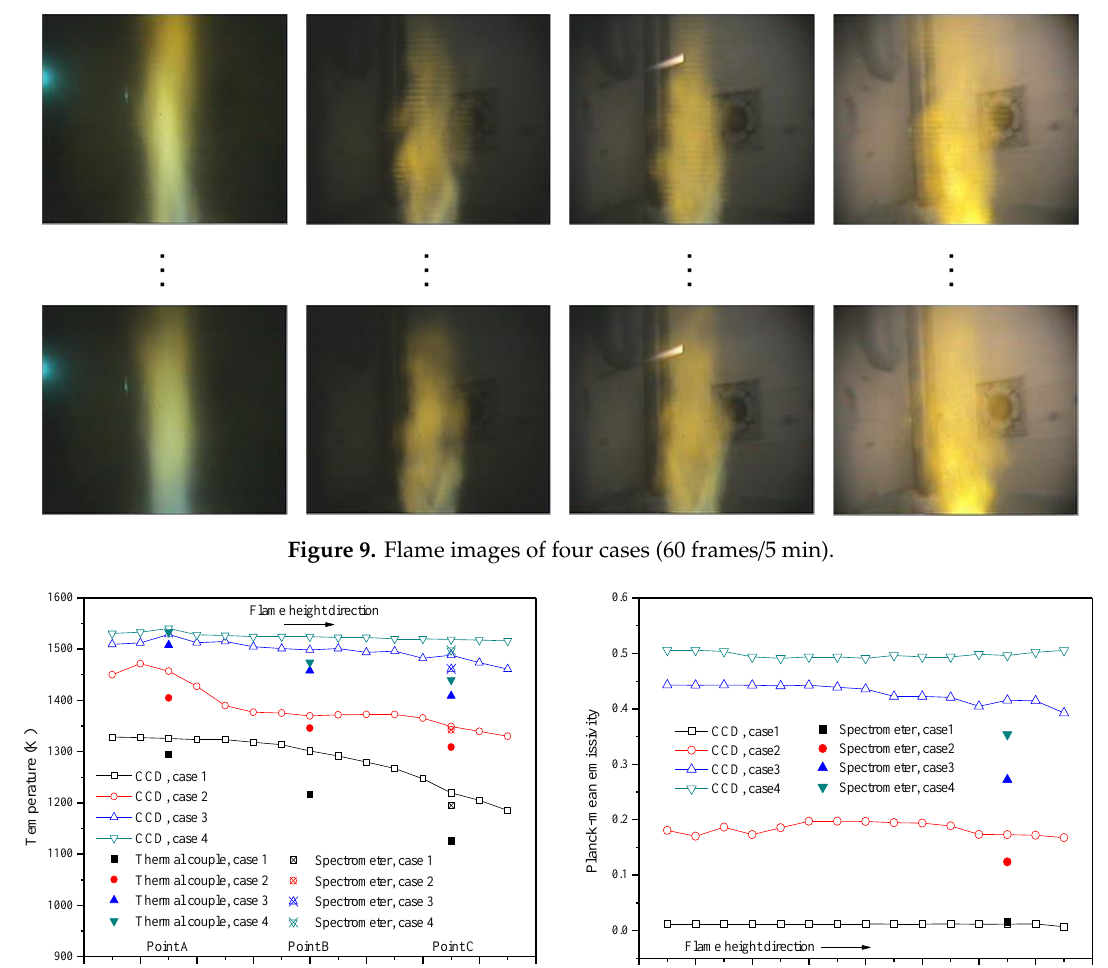
Figure 9. Flame images of four cases (60 frames/5 min).